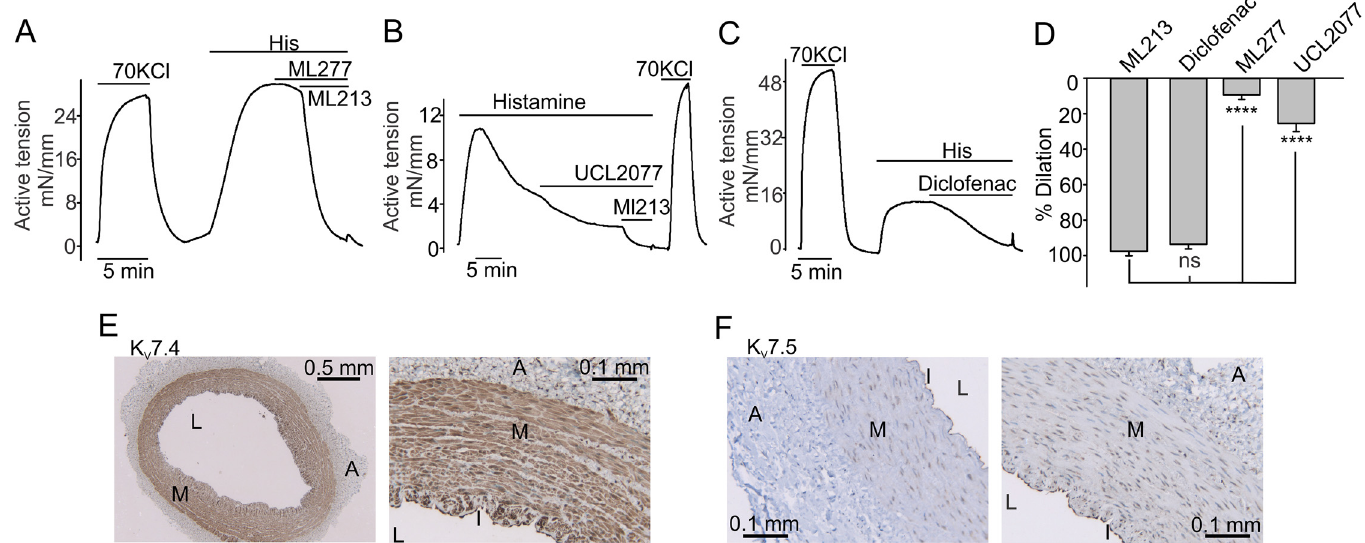
Fig 2. Immunostaining of K v 7 channels in the CA. A , 10 μ M ML277, an opener of K v 7.1 channels, did not affect the tension in histamine-pre-contracted domestic pig CA rings. A sample trace is shown. B and C , Shown are sample isometric tension recordings illustrating that a K v 7.4 activator diclofenac (200 μ M) causes greater dilations of histamine-pre-contracted rings than a K v 7.5 activator UCL2077 (50 μ M). D , Summary data for “ A-C ” (ML213: n = 12; Diclofenac: n = 5; ML277, n = 8; UCL2077: n = 5). In these experiments, we selected those domestic pig CA rings that exhibited the slower decay rate of histamine-induced contractions. E and F, Images illustrating typical immunohistochemical staining patterns for K v 7.4 and K v 7.5 isoforms in the domestic pig CA wall.